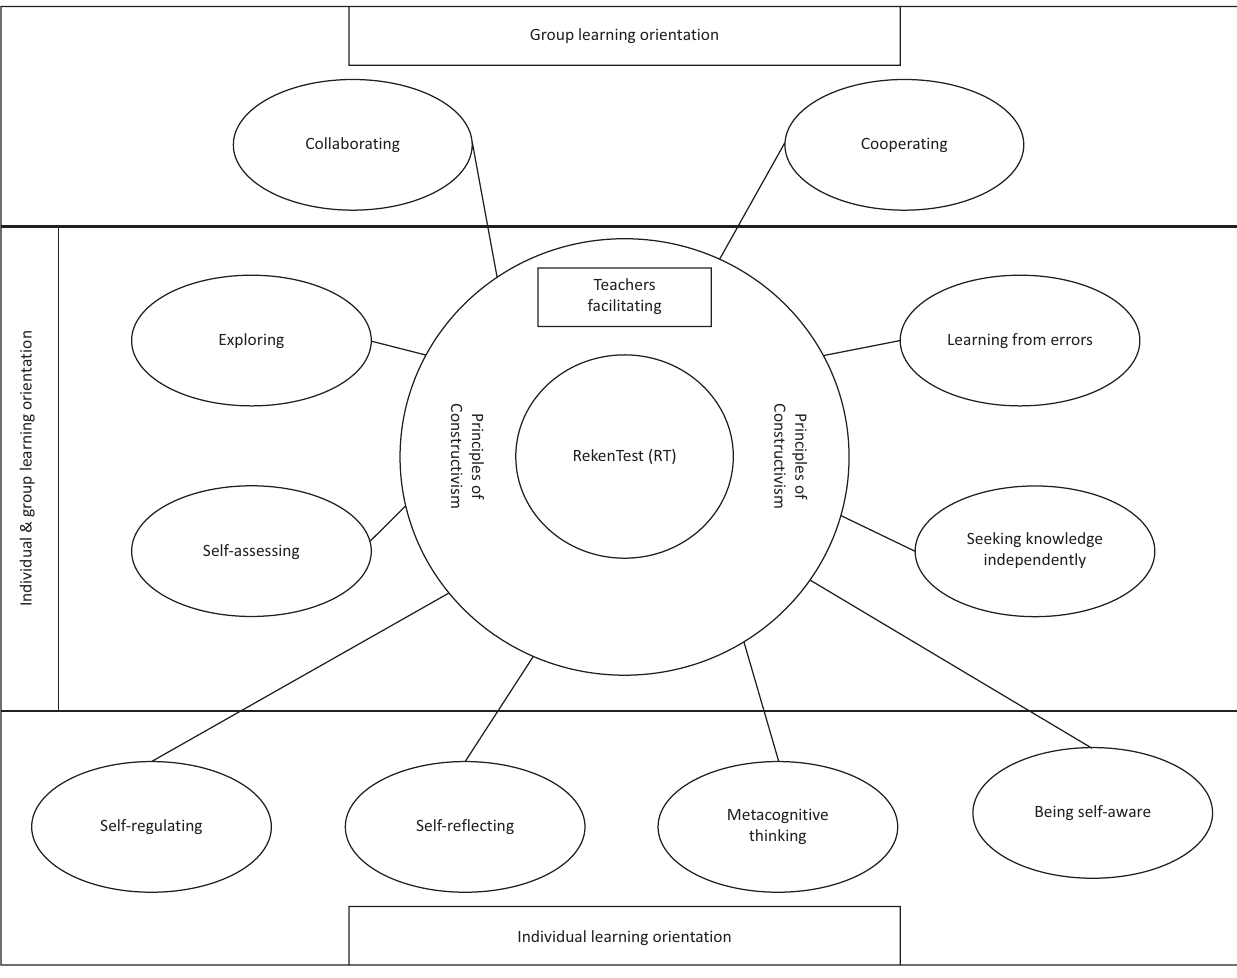
FIGURE 1: Emergent categories from the interviews that relate to the children’s learning with the Constructivism-led assistive